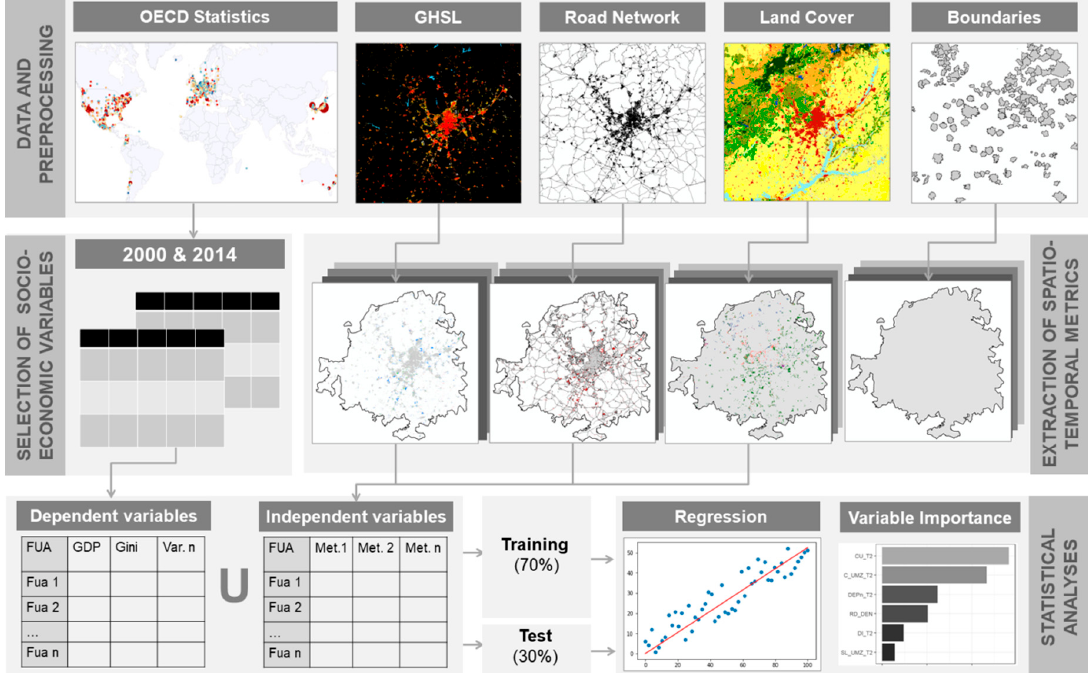
Figure 1. Workflow. First, data are downloaded and prepared for further analysis. Second, socio-economic variables are selected from the OECD database for the years 2000 and 2014. Third, spatio-temporal metrics are extracted from geographic data for each boundary individually (functional urban areas, FUAs) corresponding to the same two years. Last, socio-economic variables (dependent variables) and spatio-temporal metrics (independent variables) are combined and split into training and test samples to build regression models and rank the contribution of metrics.